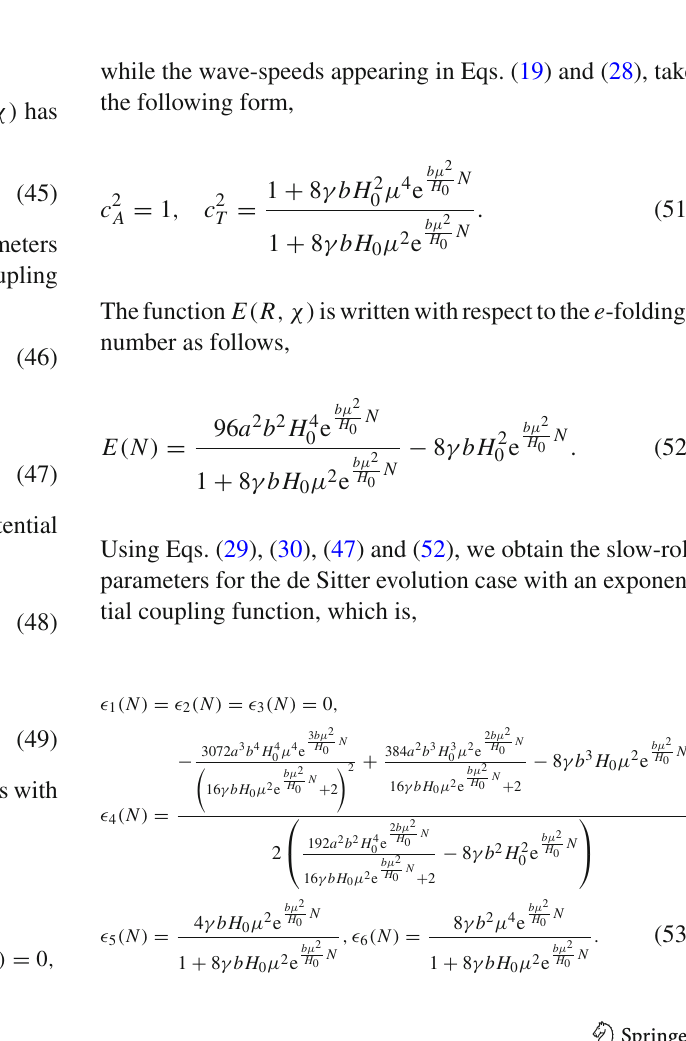
curve). The horizontal dark red line stands for n S = 0 . 9649, while the horizontal dashed red lines for the limits of its confidence interval, accordingtoPlanck2018results.Thehorizontalblacklinesetsthelimit r = 0 . 064 from the same results, while the dashed black an older upper boundary of r = 0 . 07 from the